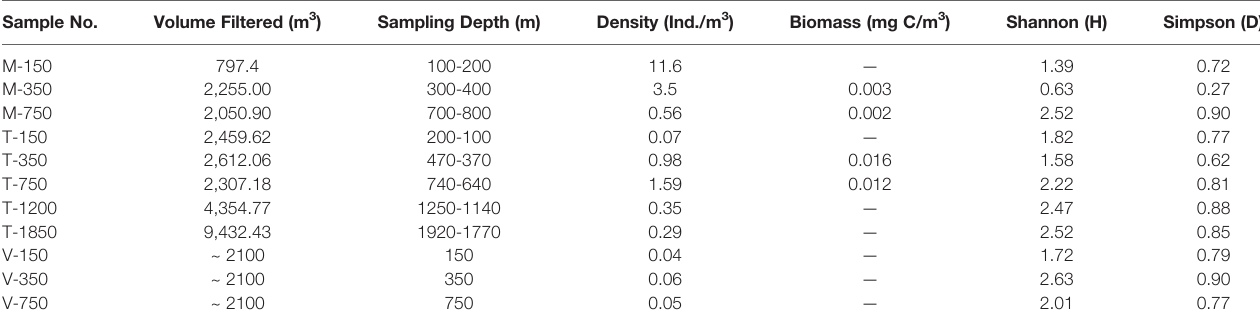
TABLE 1 | Summary of volume fi lter and depths (meters) where the net was open and obliquely towed, animal density, carbon biomass, and diversity indices for each community, where M = MOCNESS, T = Tucker, and V = ROV video. Sample